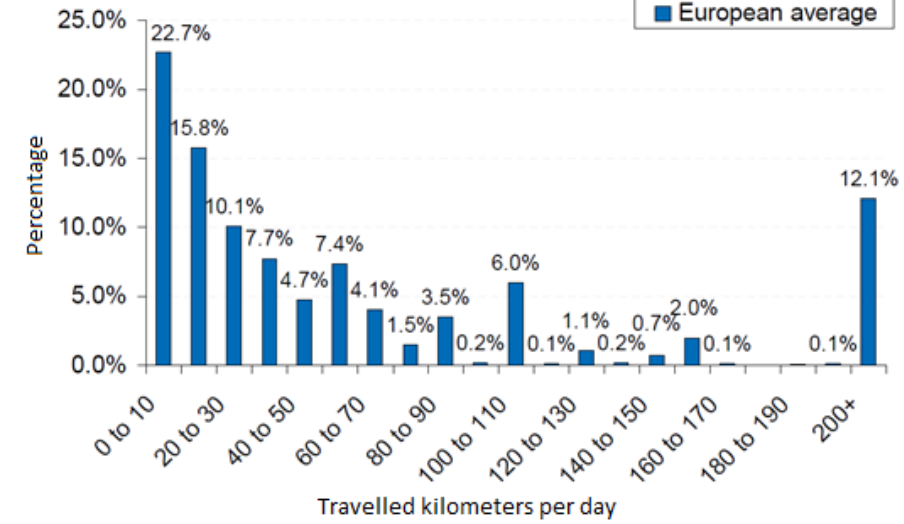
Figure 3. European average travelled per day on weekday [18].